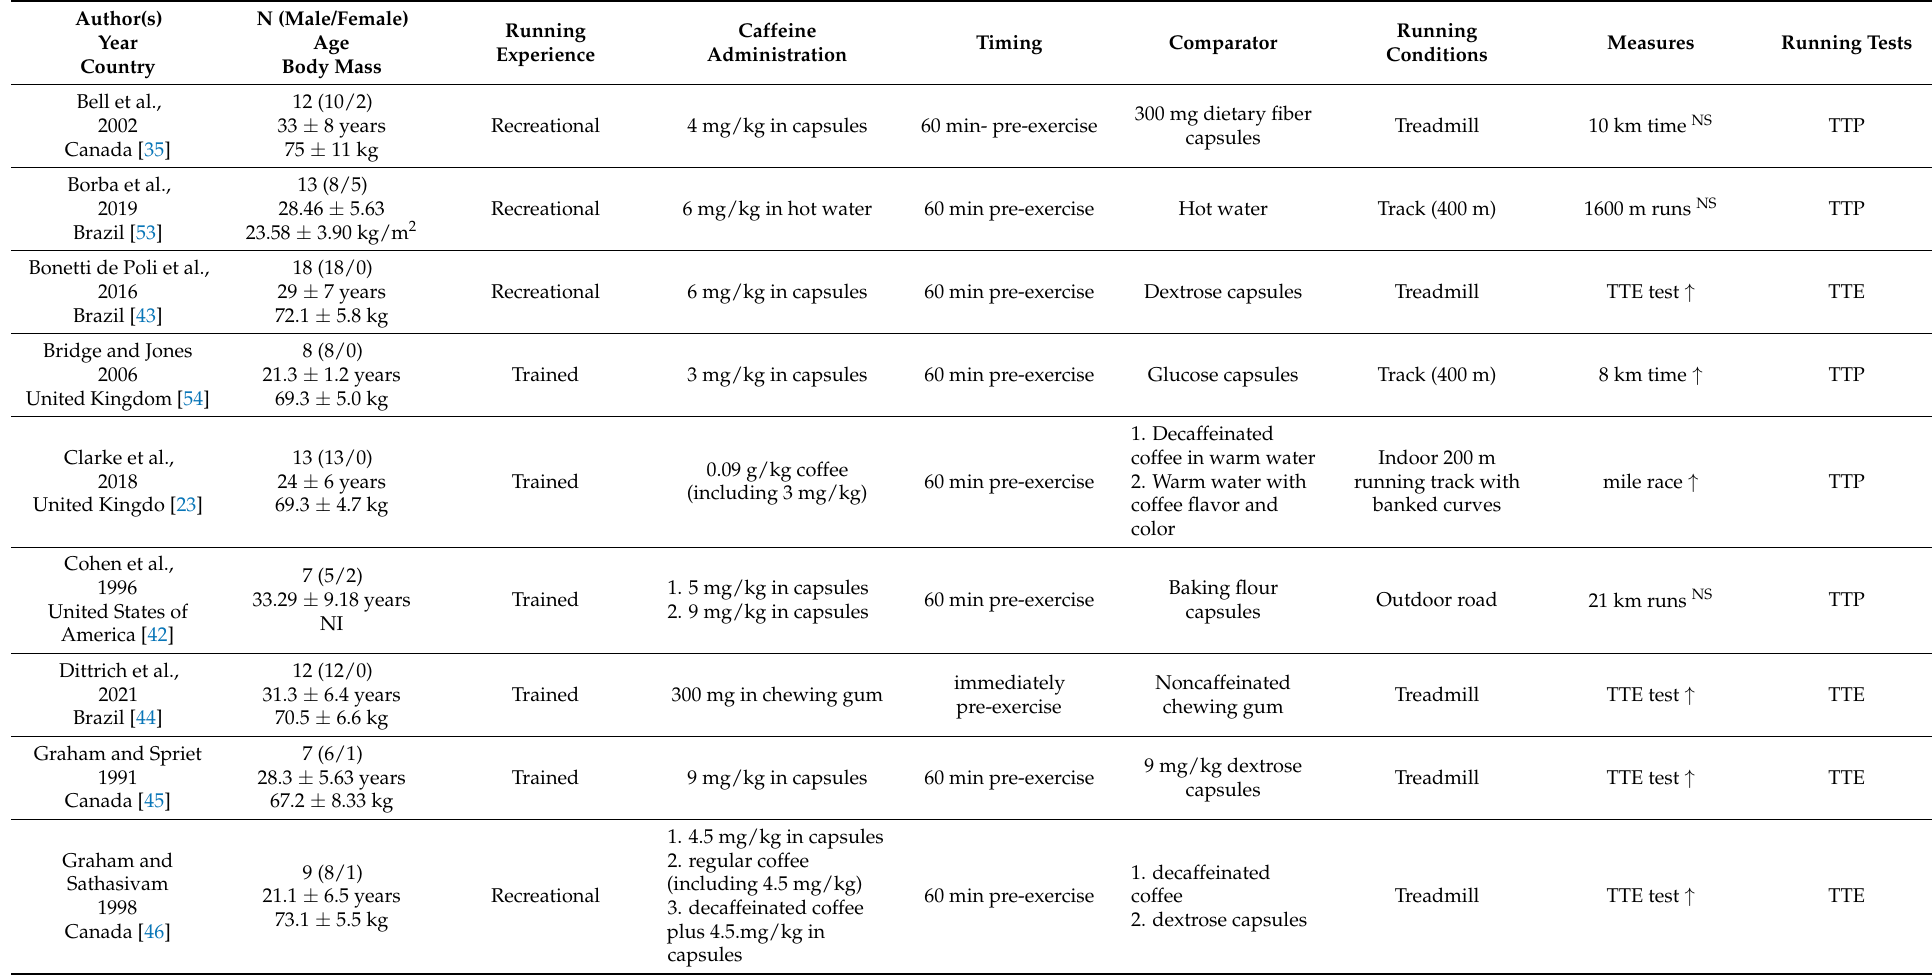
Table 2. Detailed characteristics of included trials ( n =